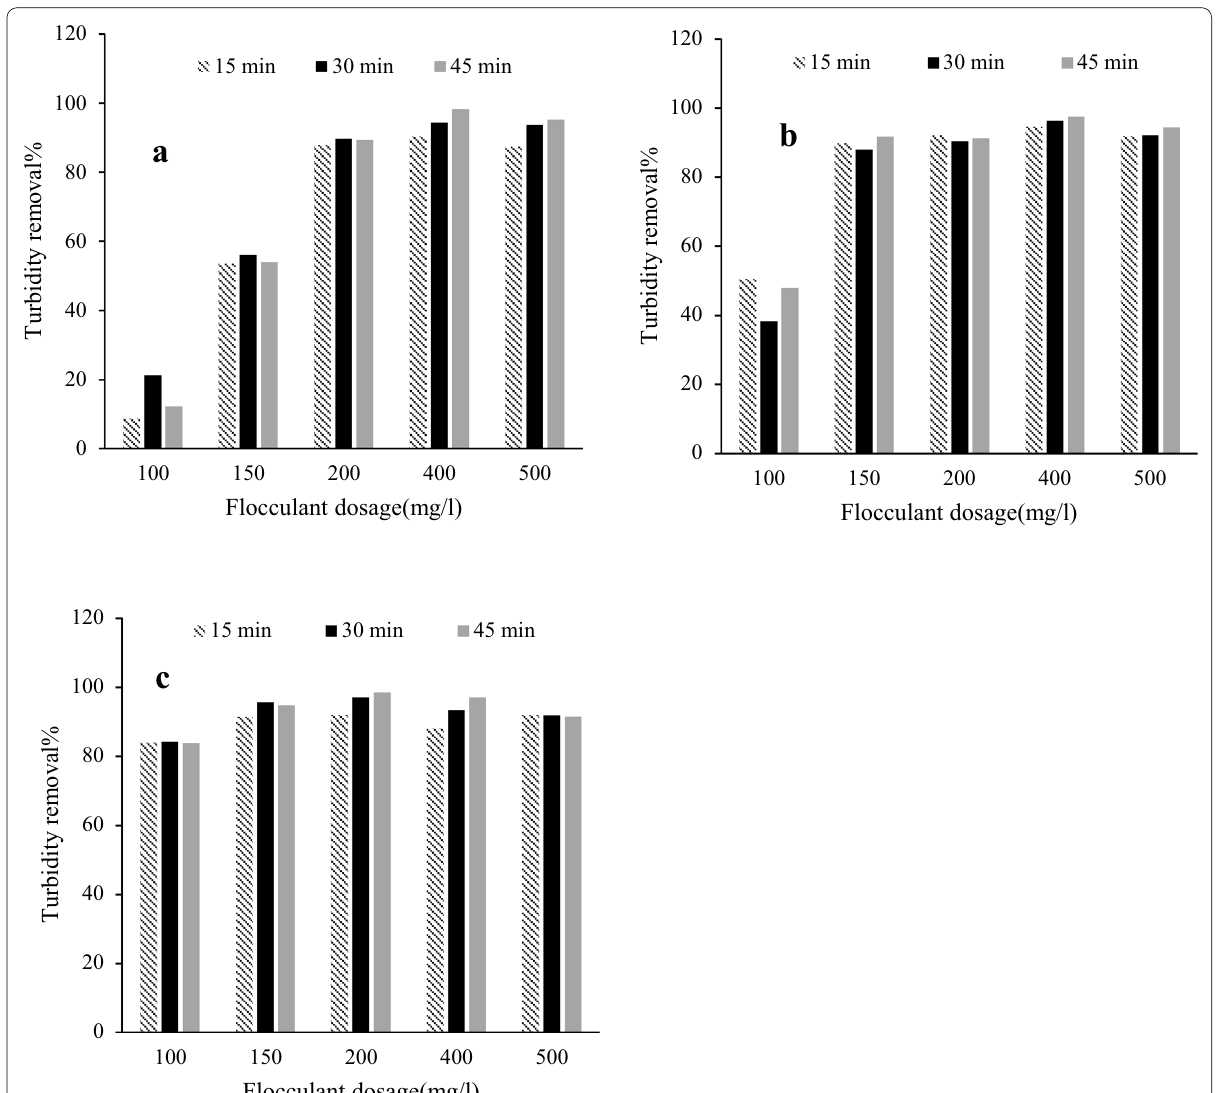
Fig. 5 The performance of the synthesized flocculant for turbidity removal from kaolin suspensions at the initial turbidity of 500 NTU considering different settling times at a pH 6, b pH 7, and c pH